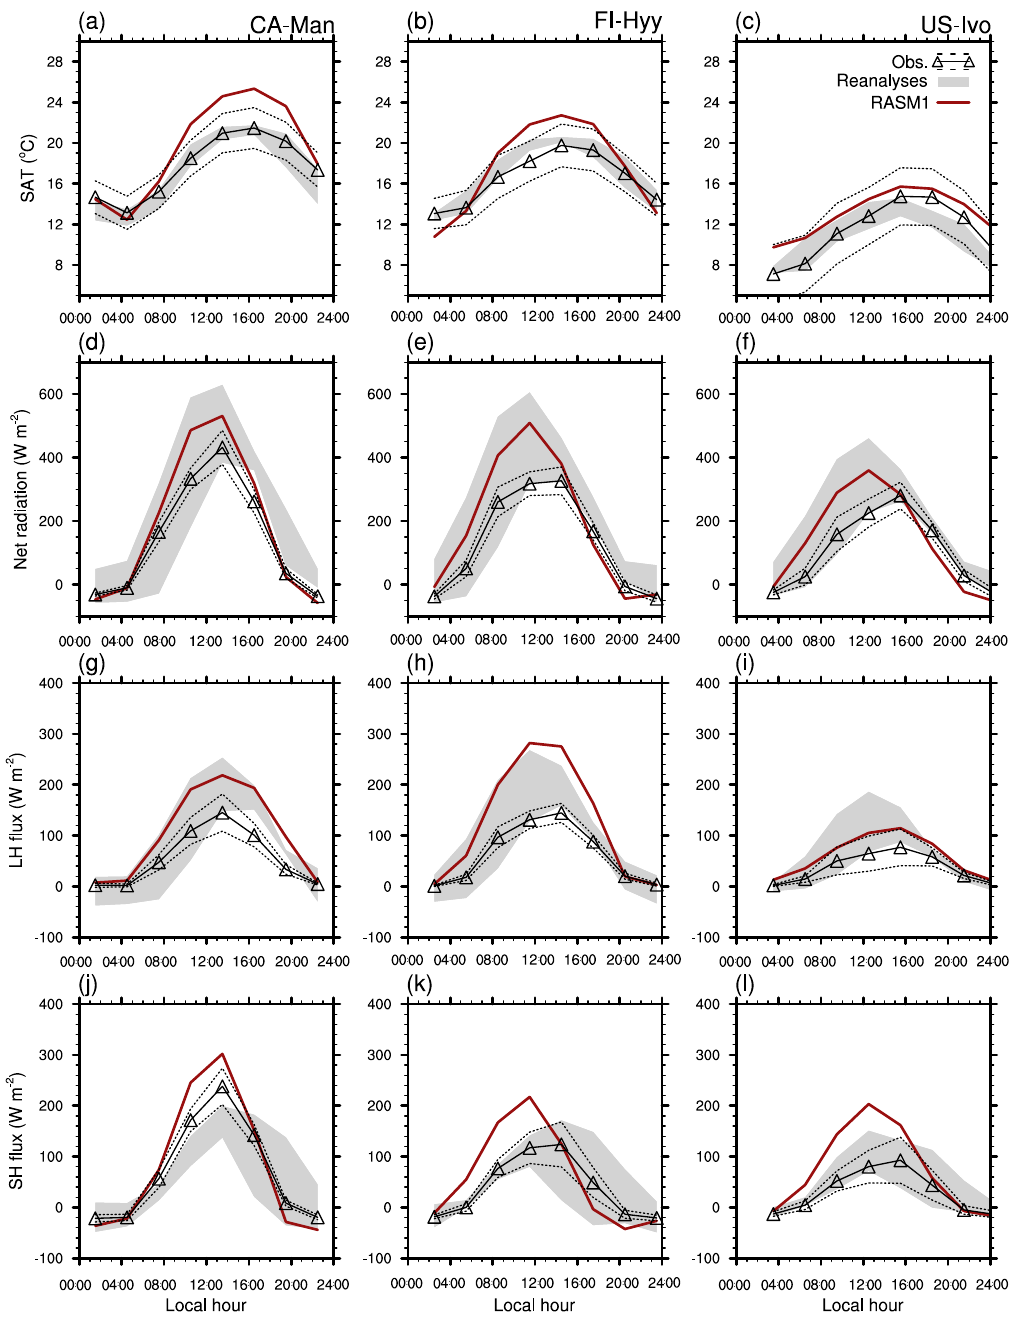
Figure 10. Mean diurnal cycles for July in (a–c) 2m surface air temperature (SAT), (d–f) net radiation, (g–i) latent heat (LH) flux, and (j–l) sensible heat (SH) flux from flux tower observations (black), RASM1 (red), and reanalyses (spread shown as gray shading) at CA-Man (left column), FI-Hyy (center column), and US-Ivo (right column). The black dotted lines around the observation line represent the interannual variability ( ± 1 σ ) in the